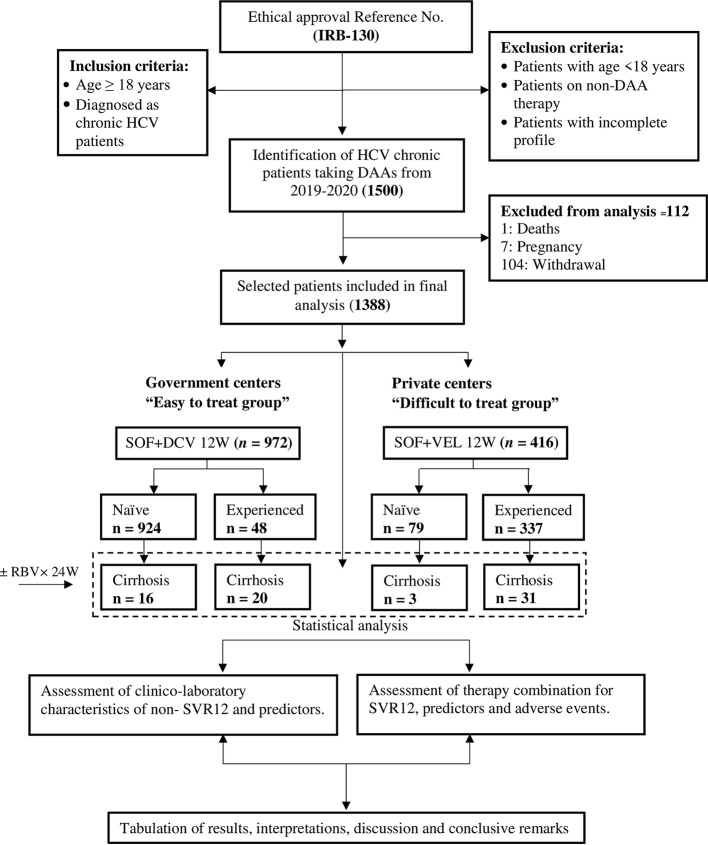
Flow chart of patient’s disposition.